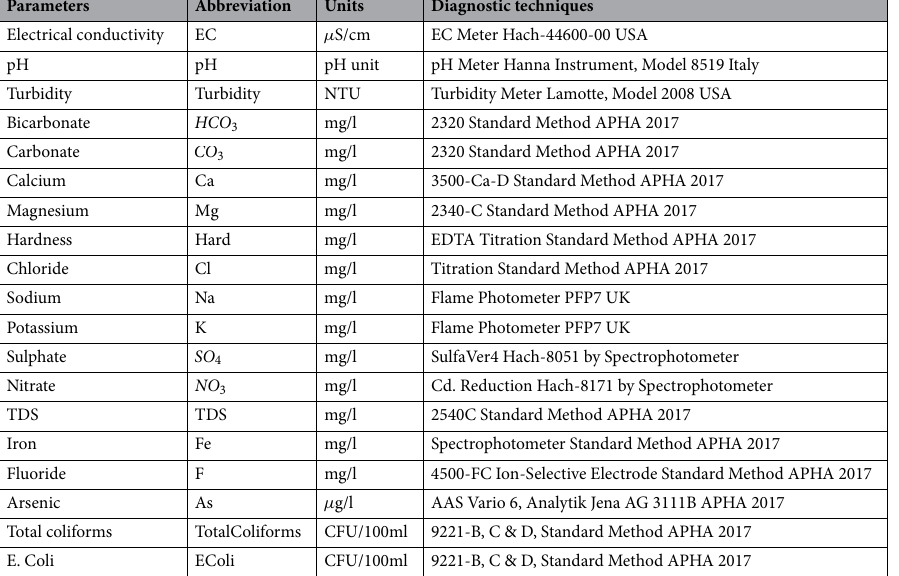
Table 3. Water components, their measuring units and diagnostic procedures.